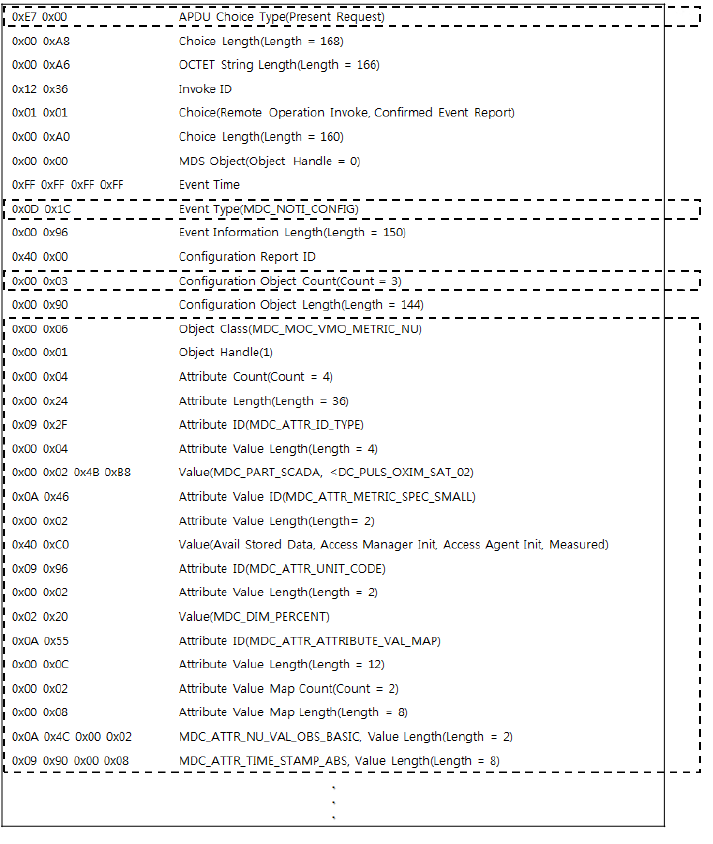
Figure 9. An example of the process described in Figure 8 (ISO/IEEE 11073 Present (Notice Configuration) Request message).